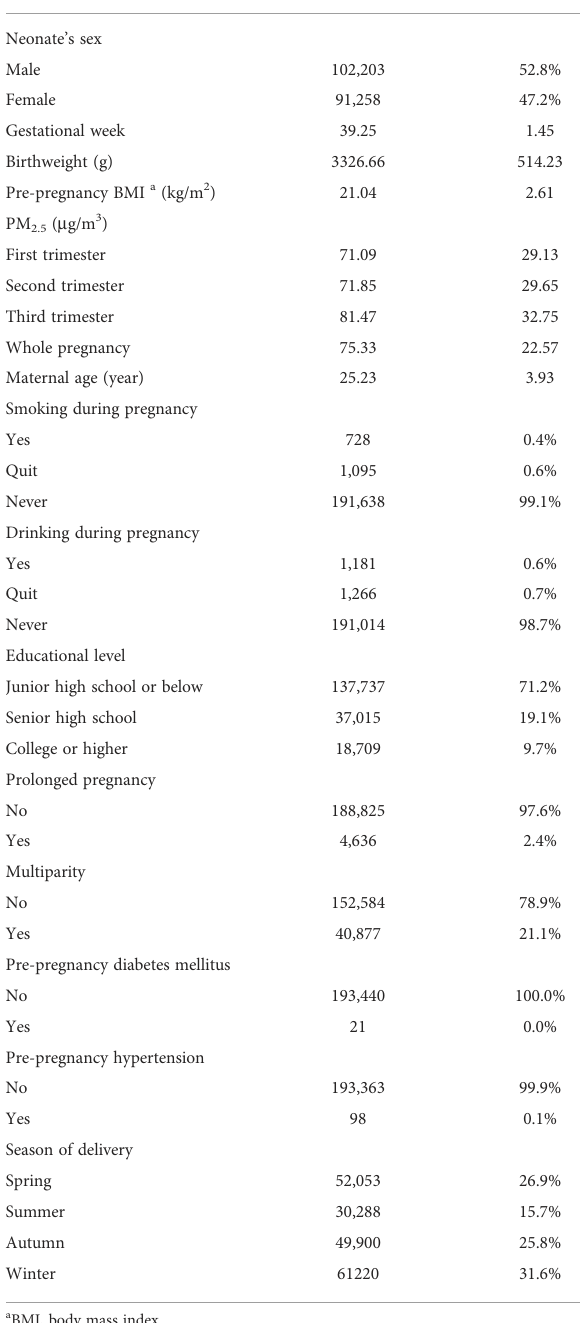
TABLE 1 Characteristics of the included and excluded pregnant women and neonates.